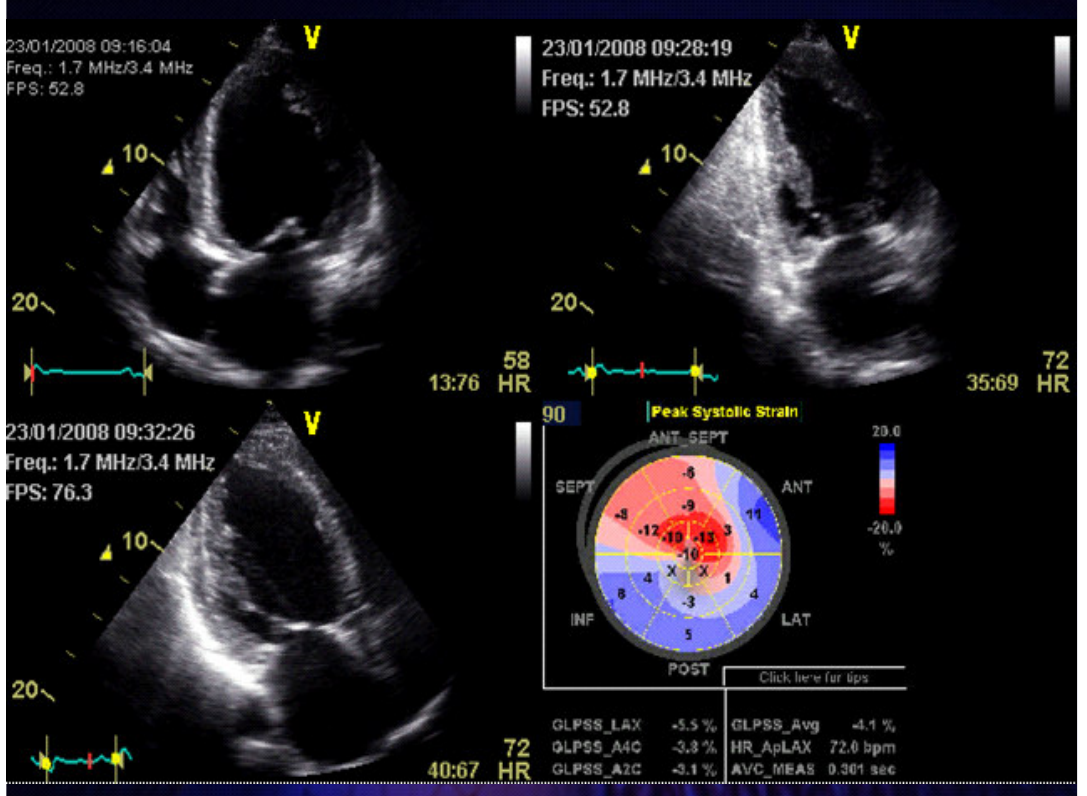
FIGURE 1 . GLPSS in patients with CAD and severe LV dysfunction, GLPSS = –4.1% , note that tracing of the endocardium through apical four-, two-, and three-chamber views yield the bulls-eye in two-dimensional echocardiography.